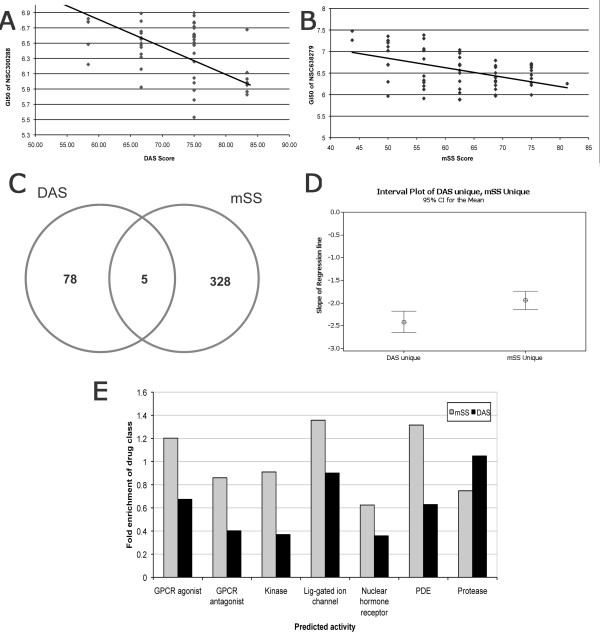
Correlation between senescence scoring and cell line compound sensitivities. Regression analysis was performed comparing DAS and mSS senescence scores derived from the NCI60 panel (figure 3, dataset GSE5846) with GI50 values for each cell line for ~1500 compounds reported in [44]. Representative regressions for DAS and compound NSC300288 (A) and mSS and compound NSC638279 (B) are shown. (C) Quantification of all compounds showing significant regression against DAS or mSS. (D) Characterisation of relationship between DAS/mSS and drug sensitivity. The slope of the regression for each significant DAS/mSS related compound was quantified. The figure shows the mean value across all significant compounds. (E) Activity modelling for significant compounds. Compounds were assigned predicted activity based on a decision tree model relating chemical similarity to a dataset of compounds with known activities. The proportion of compounds from DAS or mSS significant lists falling into each activity category is shown normalised to target class representation in the total compound set.